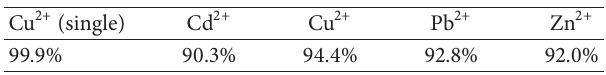
Table 1: Elemental analysis of lignitic humic acids (normalized on dry ash-free sample).